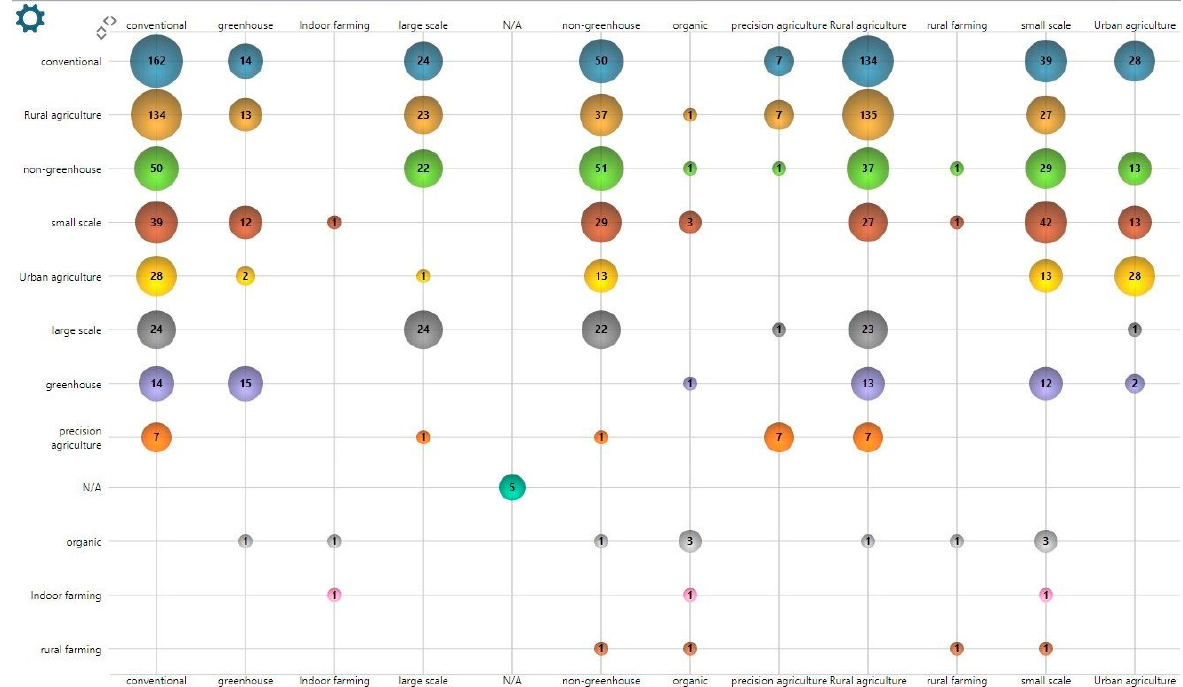
Figure 6. The relations between the types of agriculture. Obtained using VantagePoint.